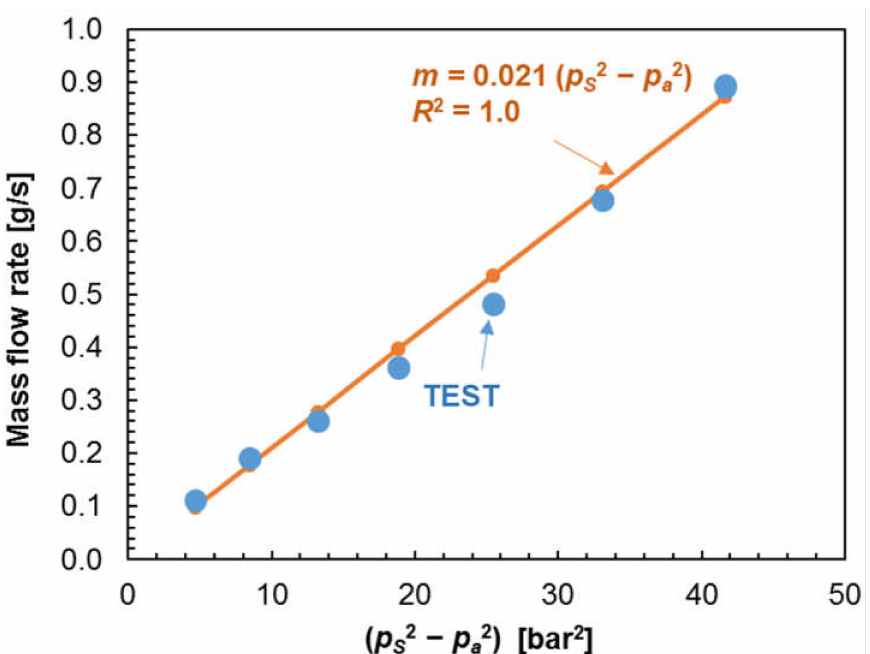
. M max vs. ( p S 2 − p a 2 ) and a line fit (no shaft